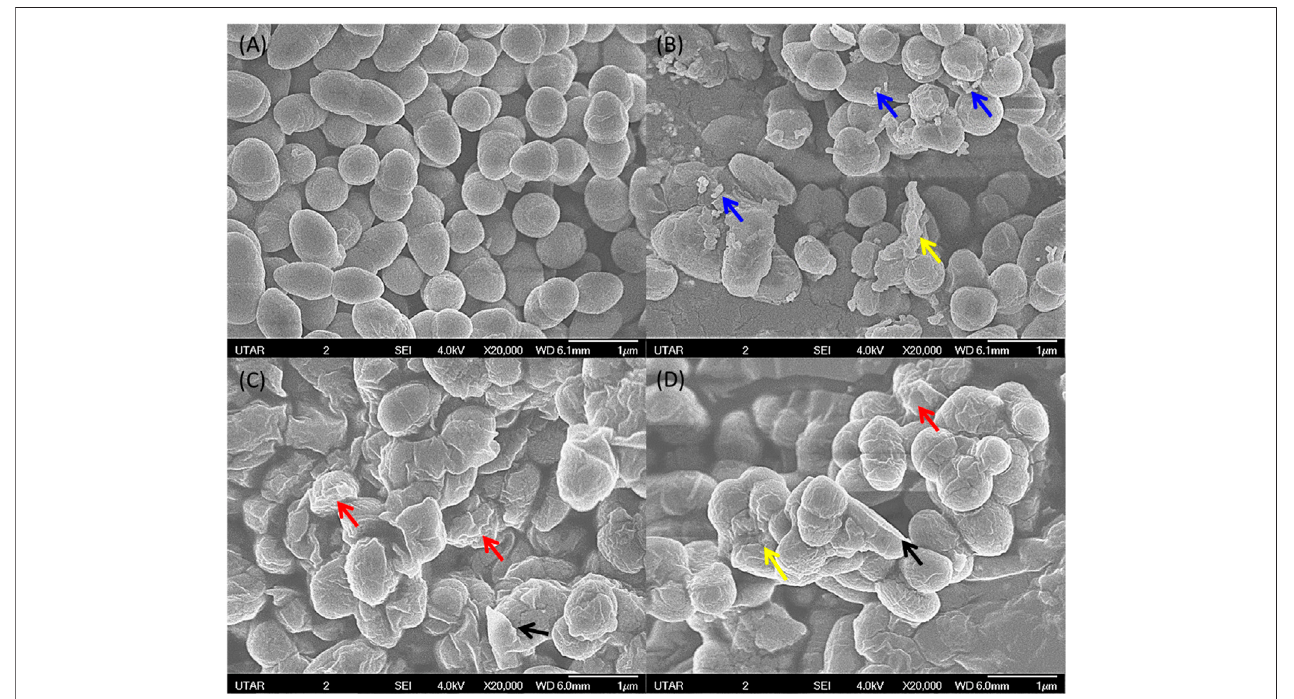
FIGURE11| SEMimageofnegativecontrolfor E.faecalis withsmoothsurfaceandintactcellwall (A) . E.faecalis upontreatmentwith160 μ g/mlofZnONPsat24 h (B,C) and (D) showing attachment of NPs (blue arrow), wrinkled cell surface (red arrow), rupture of cell membrane (black arrow), and cell distortion (yellow arrow).